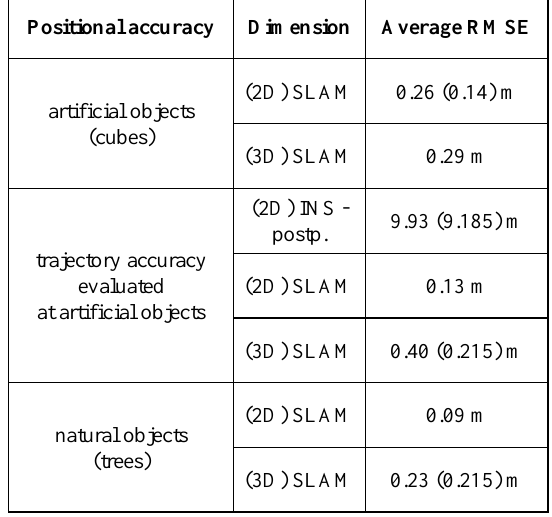
Table 1. Results of positional accuracy assessment – average RMSE values (in parentheses - the values after counting out the systematic error).